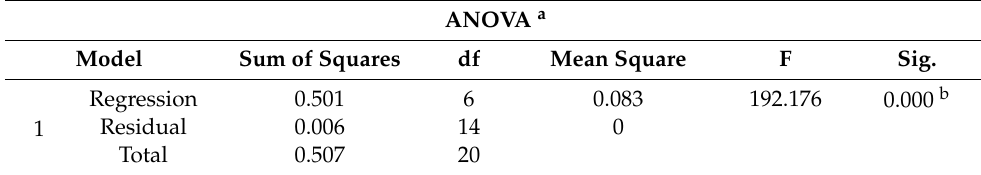
Table 2. ANOVA method for the